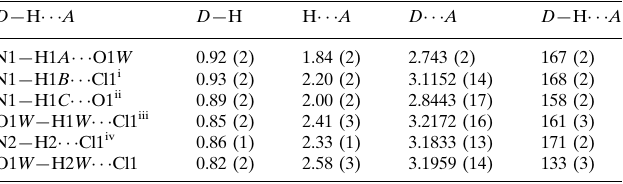
Hydrogen-bond geometry (A˚ , (cid:3)